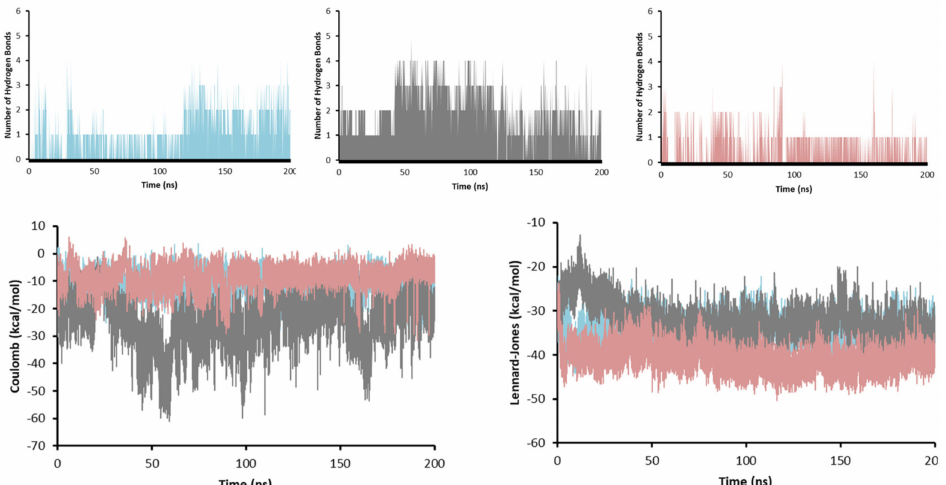
Figure 9. Number of hydrogen bonds, and Coulomb and Lennard-Jones energies 11c (cyan), 11d (gray), and 11e (pink) in complex with InhA during the 200 ns of